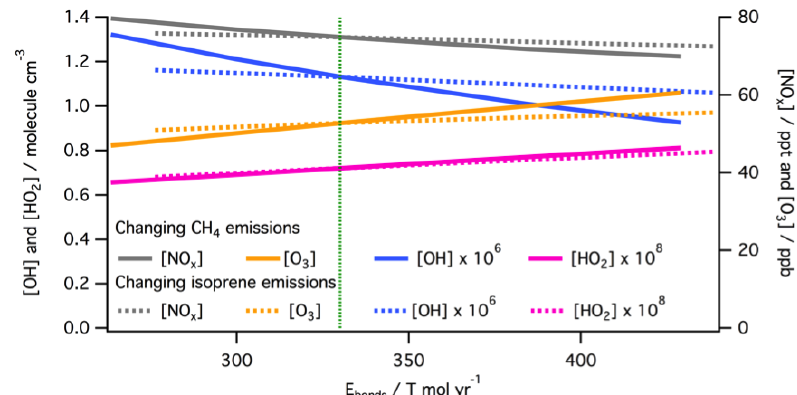
Figure 9. The effect of oxidisable bond parent species on OH, HO 2 , O 3 and NO x concentrations. Global mean [OH], [HO 2 ], [O 3 ] and [NO x ] for simulations where the effective CH 4 emission (solid lines) and isoprene emission (dashed lines) were changed, against model E bonds . The dashed vertical green line indicates E bonds in the base simulation (330Tmolyr − 1 ) .